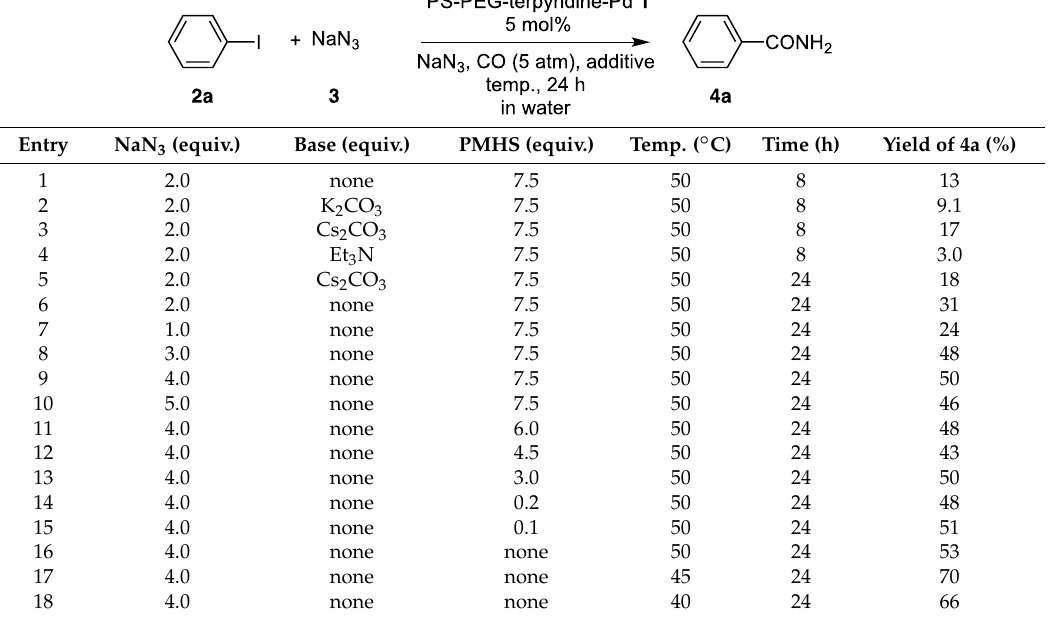
NaN 3 Entry NaN 3 (equiv.) Base (equiv.) PMHS (equiv.)